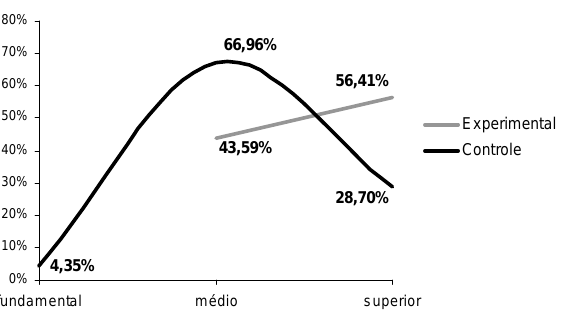
Figura 2. Distribuição dos Participantes que Trabalhavam, Figura 2. Distribui(cid:231)ªo dos participantes, que trabalhavam em 2001, por Nível de Ensino em 2001, por n(cid:237)vel de ensino.